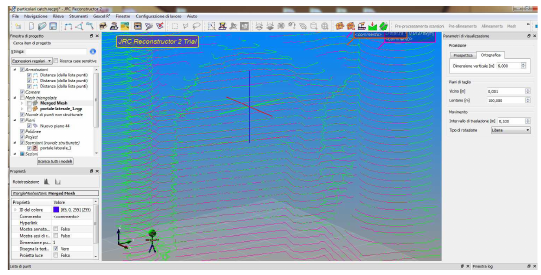
Figure 10: Part of the lateral entrance mesh alignment